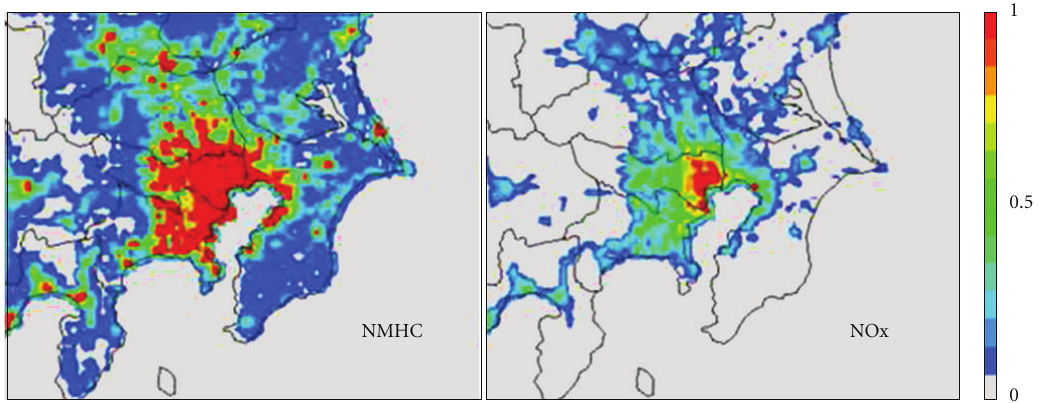
Figure 5: Hourly emissions data for the CMAQ model at 14:00 JST (mole/s/grid). Table 3: Initial and boundary conditions of some pollutants (in ppb) for the CMAQ model.